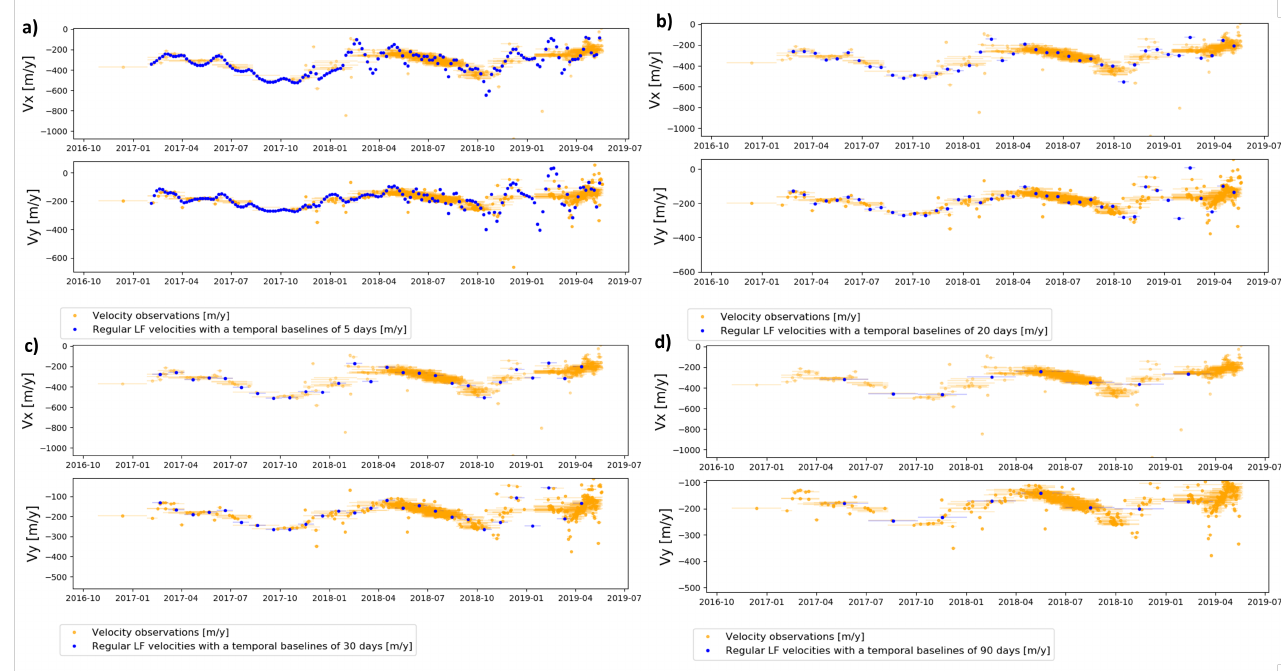
Figure 6. Velocity observations (in gold) overlayed with the RLF time series in blue for the point of coordinates (-43.532,170.134) labeled as the blue point in Figure 1. The RLF time series have a temporal sampling of a) 5 days b) 20 days c) 30 days and d) 90 days.